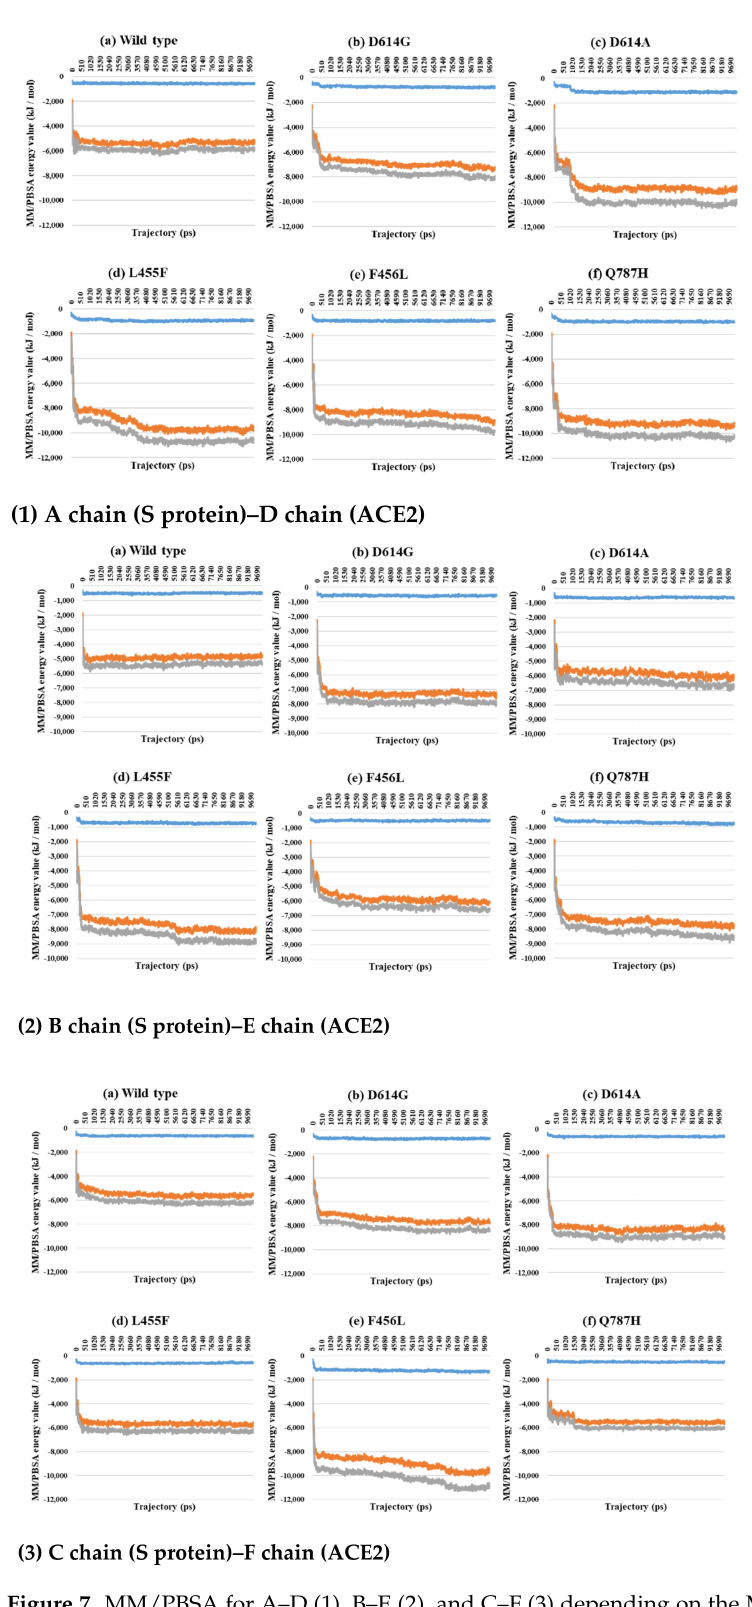
Figure 7. MM/PBSA for A–D (1), B–E (2), and C–F (3) depending on the MD trajectories in the 3- open-complex form (7A98). ( a ) Wild type, ( b ) D614G, ( c ) D614A, ( d ) L455F, ( e ) F456L, and ( f ) Q787H. The X axis denotes trajectory (ps), and the Y axis denotes MM/PBSA energy value (kJ/mol). Blue color indicates van der Waals energy between S protein and ACE2, orange color indicates electrostatic energy, and gray color indicates total